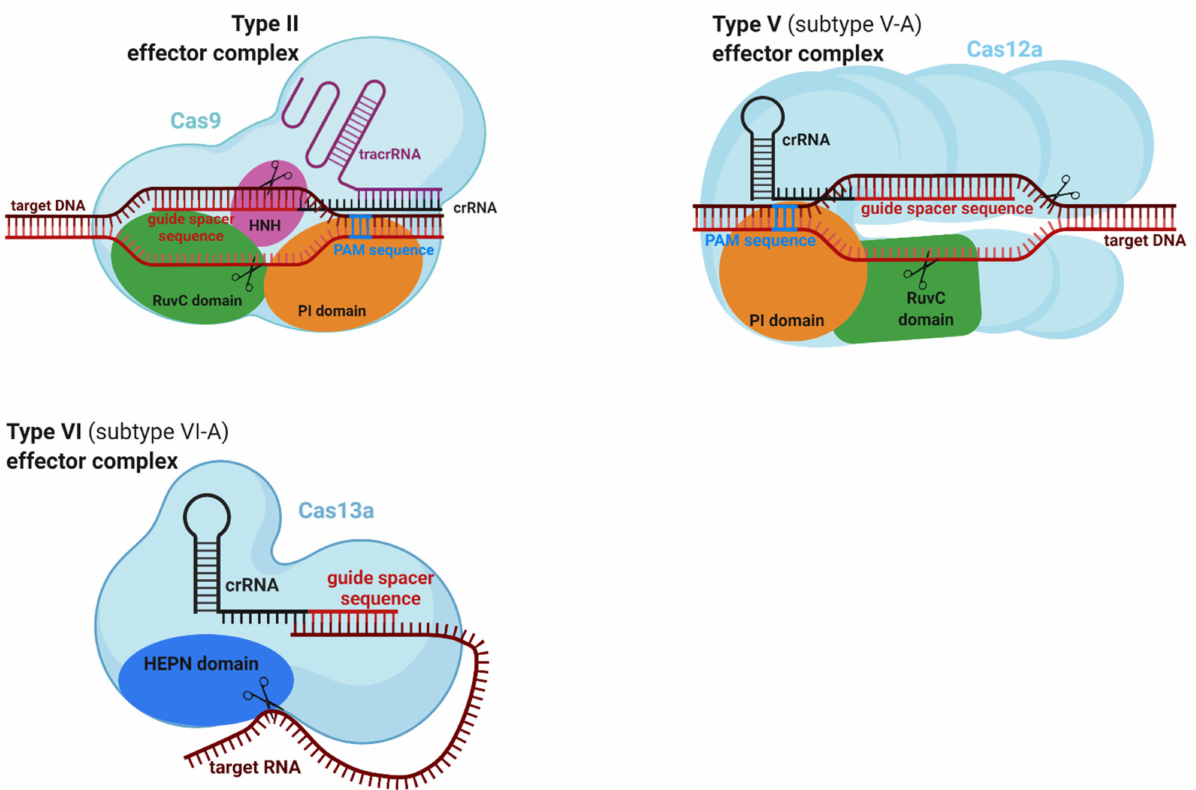
Figure 5. Selected single effector complexes of class 2. The figure was created with BioRender.com, accessed on 15 February